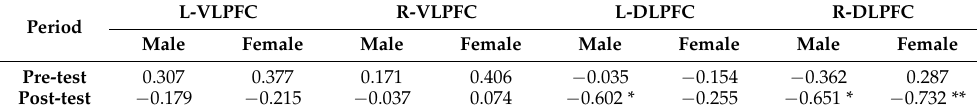
Table 6. Correlation results between fNIRS and behavioral (Pearson’s correlation coefficient r).